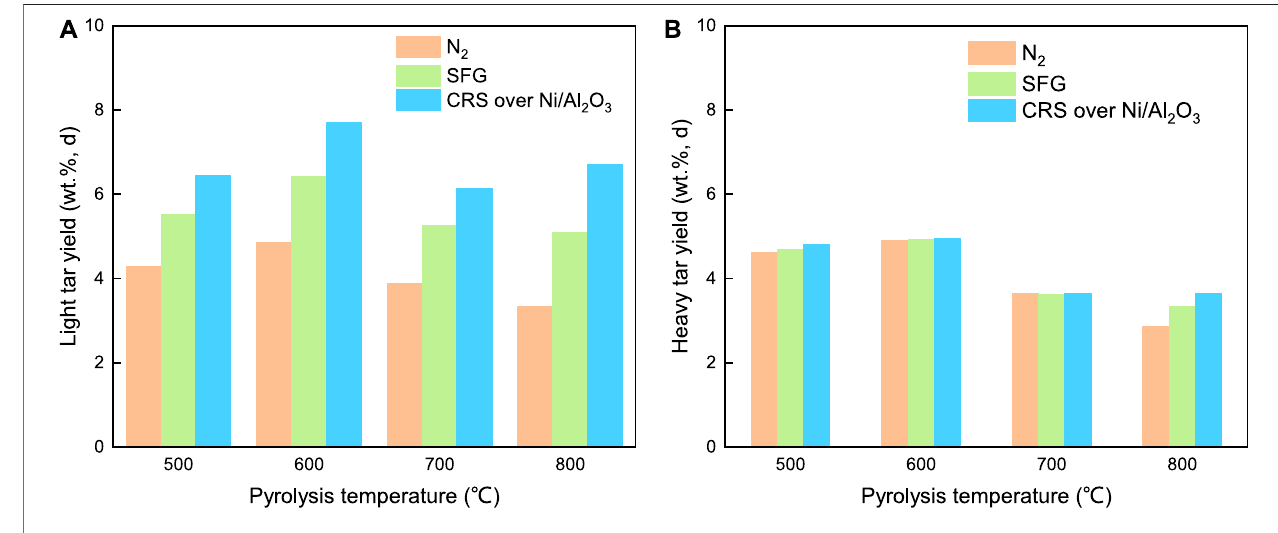
FIGURE 6 | The effect of the pyrolysis atmosphere on the yield of the light tar (A) and the heavy tar (B) .